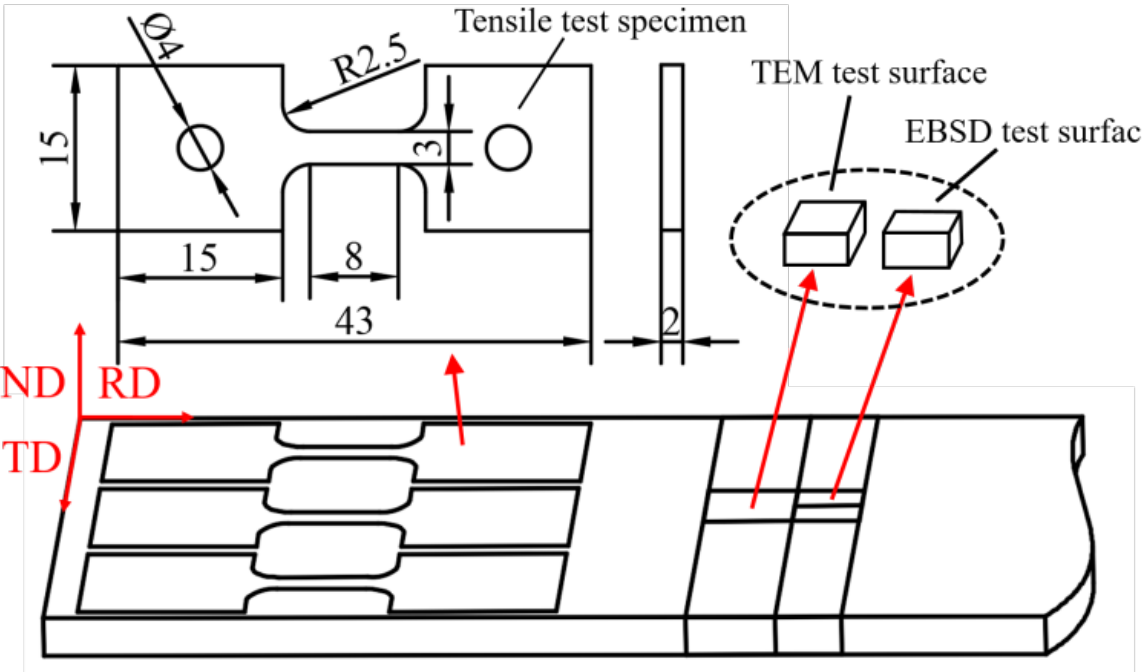
Figure 1. Positions and dimensions of the specimens for microstructure observation and tensile test.